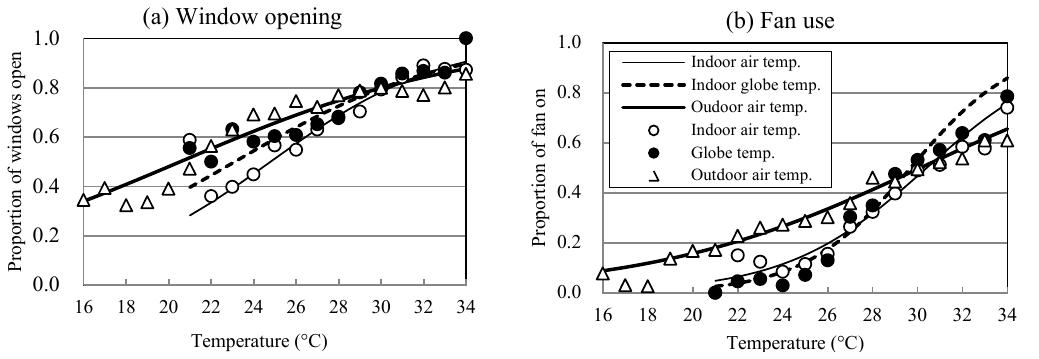
Figure 9. Relation between the use of controls and temperature: ( a ) Window opening; ( b ) Fan use. Measured values were grouped for every 1 °C for temperatures. The grouped data for samples less than 10 are not